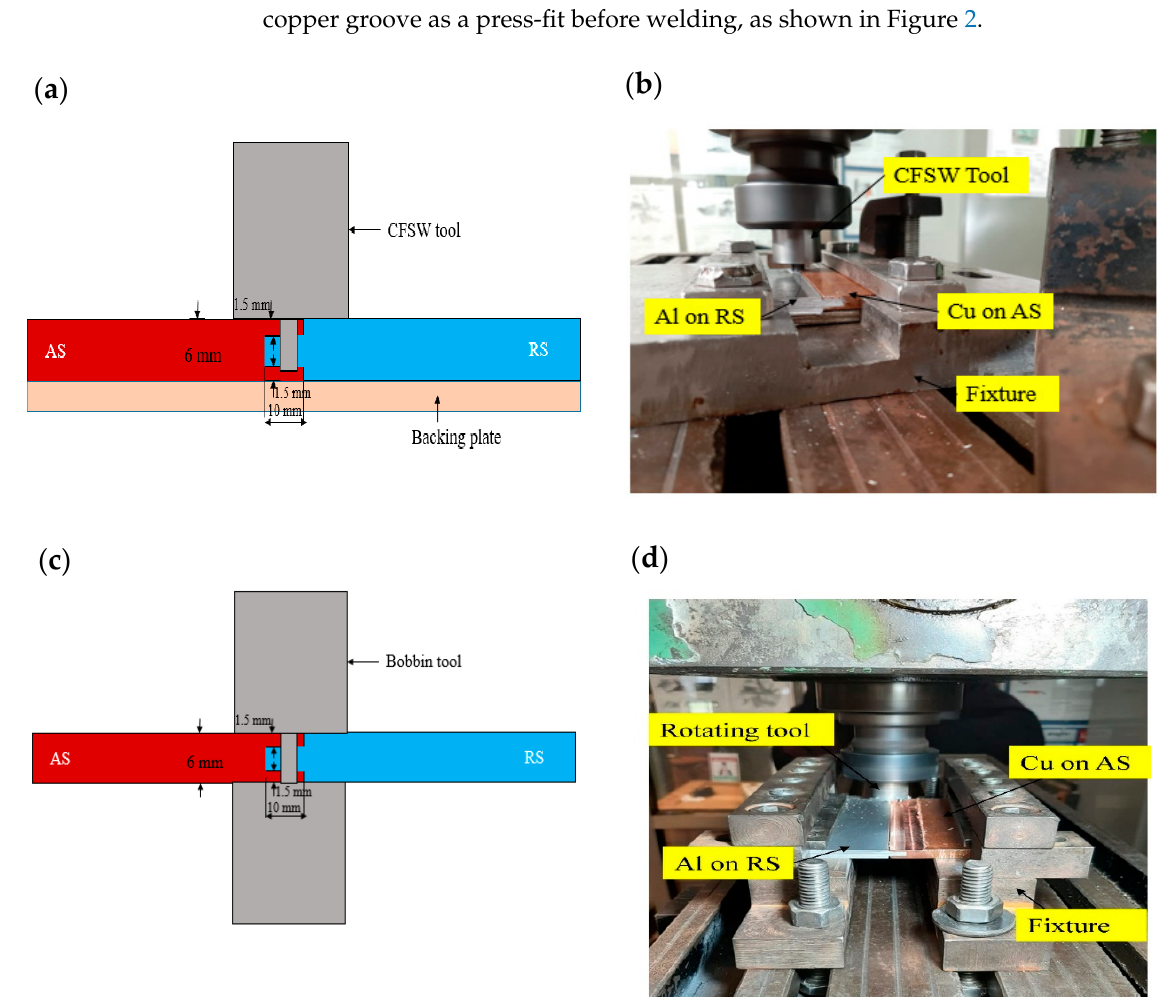
Figure 1. Stirring tool used for experiments ( a ) BTFSW tool ( b ) CFSW tool.